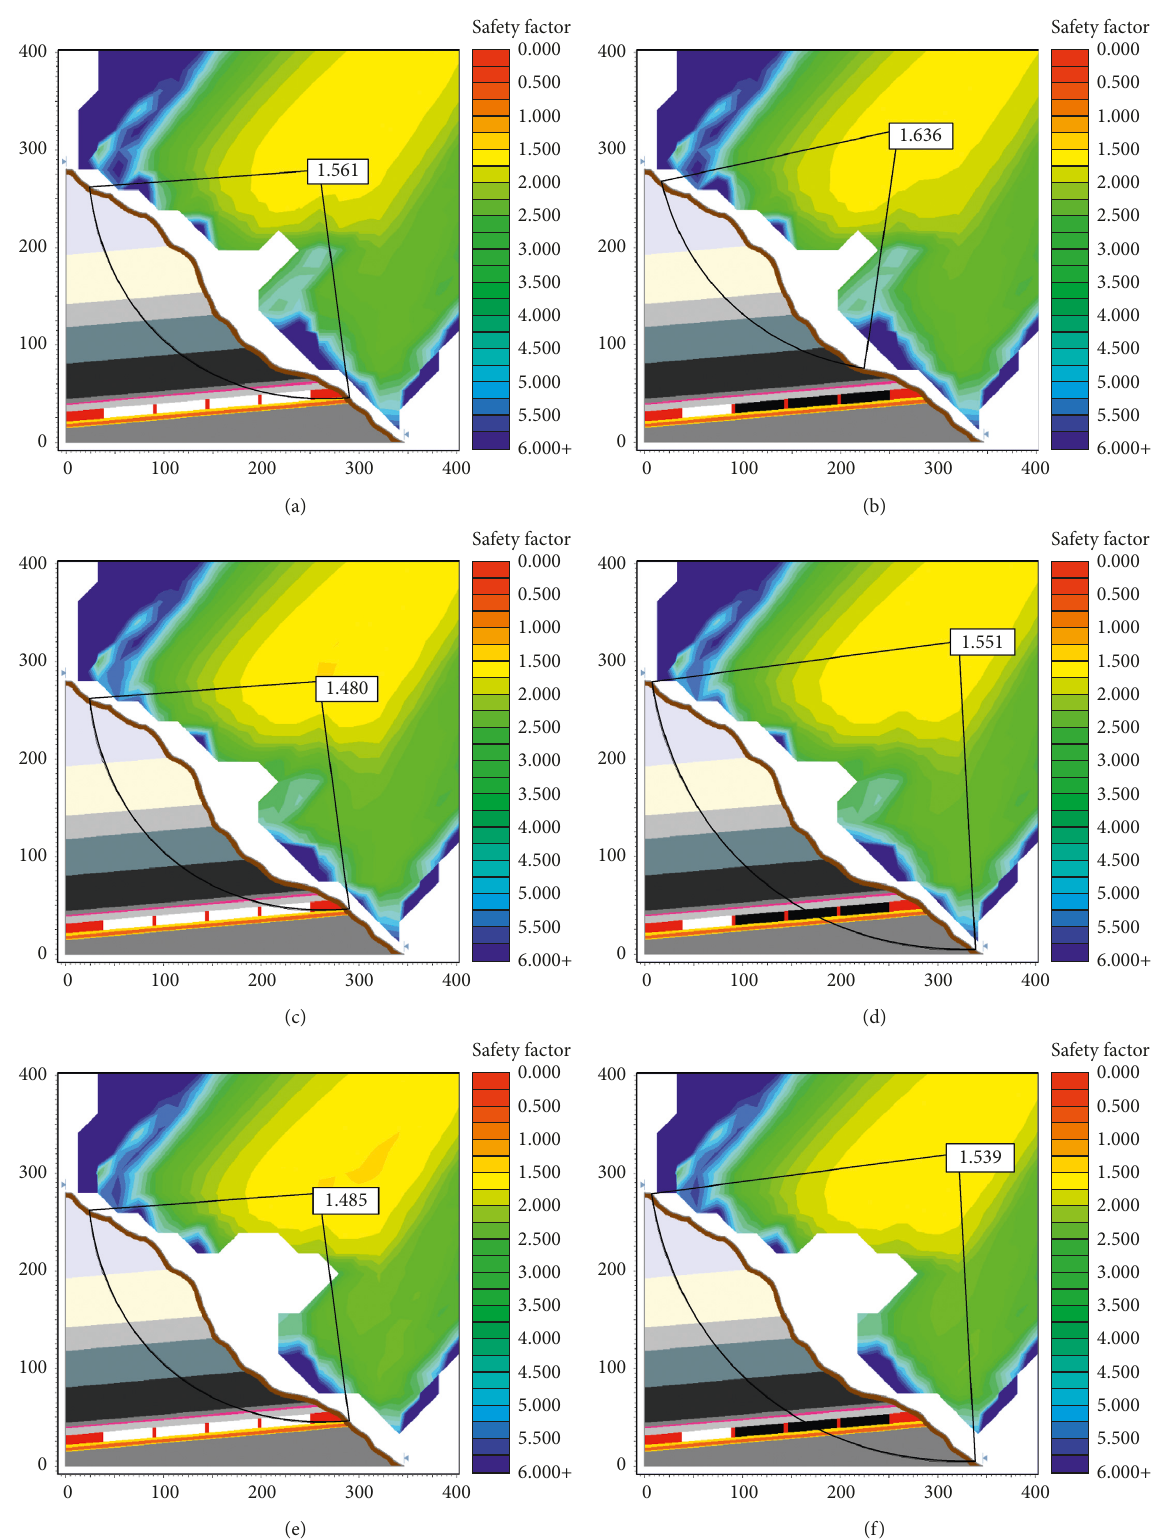
Figure 6: Safety factors of HSRS in normal operation: (a) open-stope method using simplified Bishop method; (b) backfill method using simplified Bishop method; (c) open-stope method using Fellenius method; (d) backfill method using Fellenius method; (e) open-stope method using simplified Janbu method; (f) backfill method using simplified Janbu